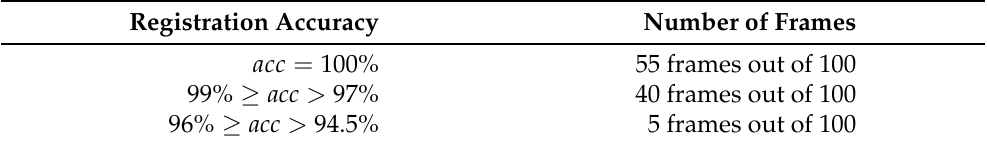
Table 3. Registration accuracy for synthetic image sequence BENCH 100 . We consider 100 pairs of consecutive synthetic images taken from the benchmark dataset BENCH6. Automatic registration was implemented by BM minimization of the cost function cost ( f ) , which was parametrized by the vector of optimized weights Λ ∗ in (17). The average registration accuracy was